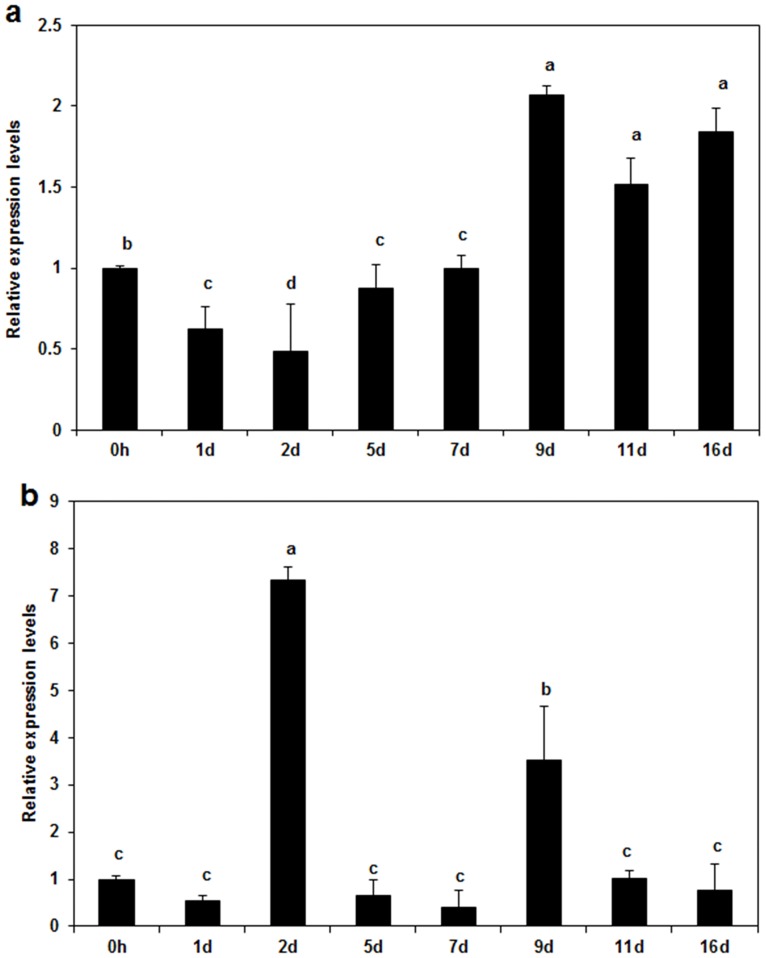
Effects of Hhs.015 fermentation broth on expression levels of CALS1 and CALS2 using EF1 as a reference gene.Gene expression levels of CALS1 and CALS2 were normalized to that of EF1 (M&M). a: CALS1 and b:CALS2. Bars represent the standard deviations. Each sample was amplified three times. Statistical significance of the differences between means was evaluated using One-WayANOVA. Different letters denoted significant differences at p<0.05 for time factor.